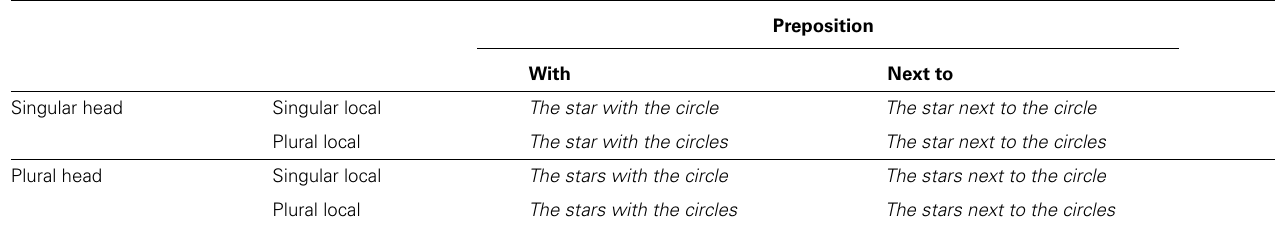
Table 4 |An example item in eight